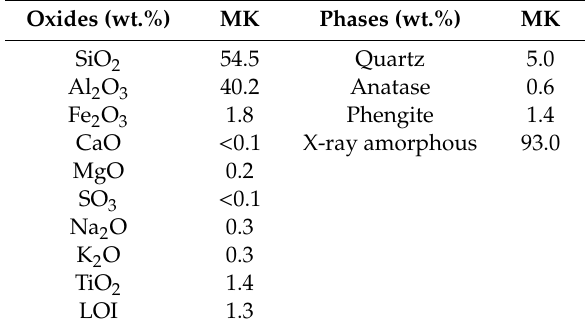
Table 1. Chemical composition, loss on ignition (LOI) and mineralogical composition of metakaolin (MK) [38,44]. Oxides (wt.%) MK Phases (wt.%) MK SiO 2 54.5 Quartz 5.0 Al 2 O 3 40.2 Anatase 0.6 Fe 2 O 3 1.8 Phengite 1.4 CaO < 0.1 X-ray amorphous 93.0 MgO 0.2 SO 3 < 0.1 Na 2 O 0.3 K 2 O 0.3 TiO 2 1.4 LOI